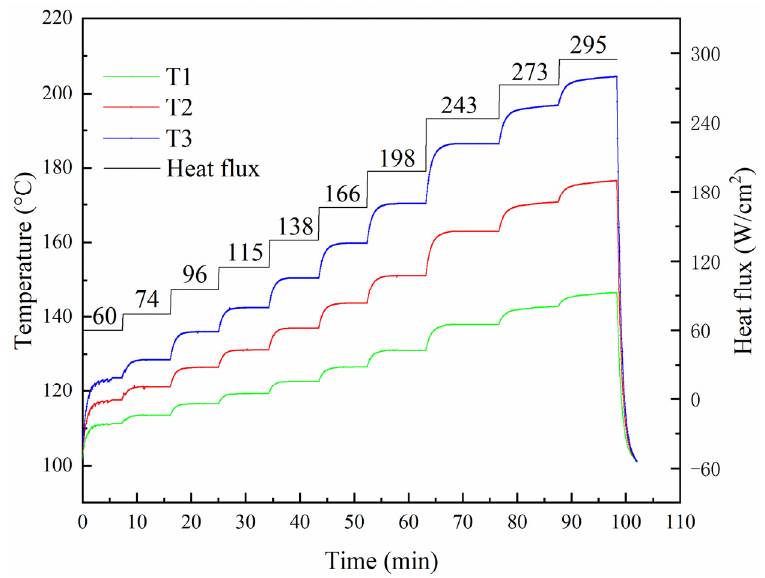
Figure 7. Temperature variation of different heat flux under continuous incremental heating mode.